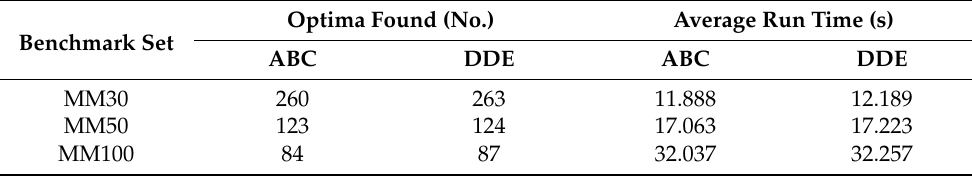
Table 6. The average runtime per MRCPSP/Max benchmark set for each algorithm. Benchmark